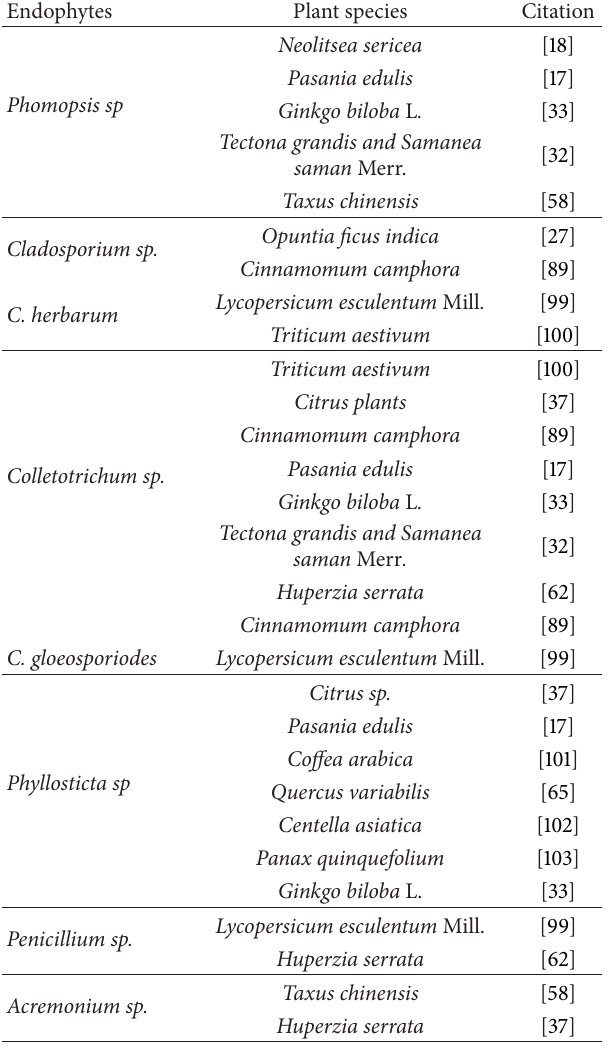
Table 1: Fungi those are commonly isolated as endophytes from different